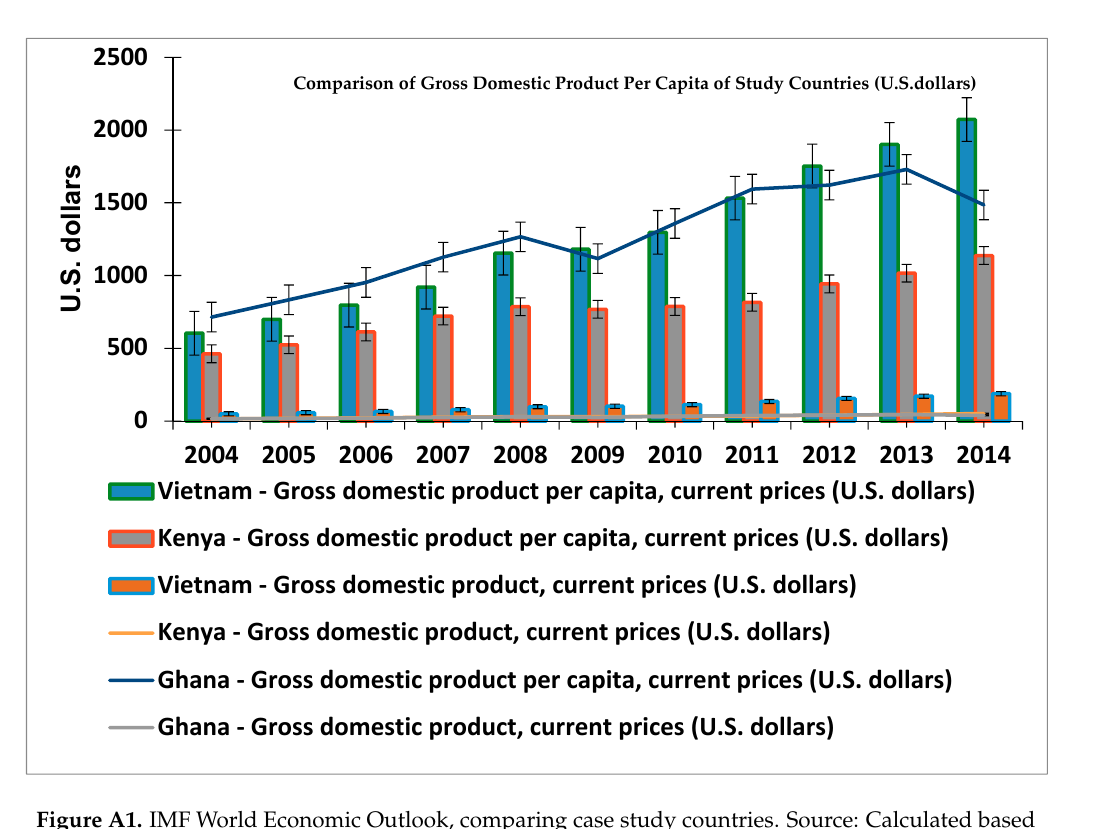
Figure A1. IMF World Economic Outlook, comparing case study countries. Source: Calculated based on IMF Data, April 2014.